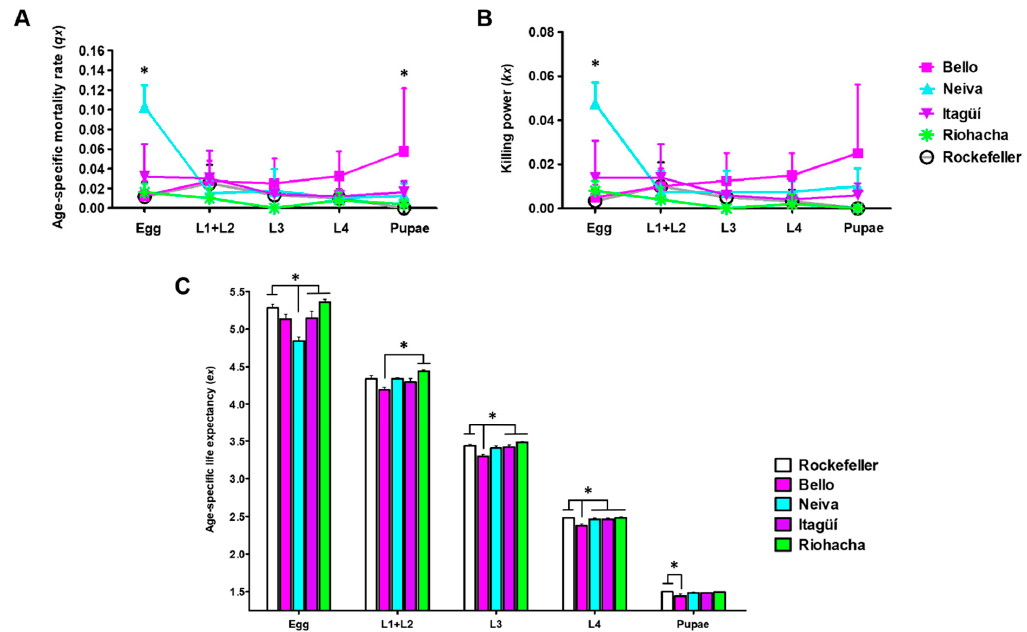
Figure 4. ( A ) Age-specific mortality rate ( qx ), ( B ) killing power ( kx ), and ( C ) age-specific life expec- tancy ( ex ) of Colombian Ae. aegypti populations reared at 28 ± 1 °C temperature, 80 ± 5% relative humidity, and 12 h light: 12 h dark photoperiod. Mean and standard deviation (SD) are shown. The total number of replicates were: Bello and Neiva (4); Itagüí and Riohacha (5), and Rockefeller control (6). Each replicate started from a cohort of 100 eggs. One-way analysis of variance (ANOVA) was conducted (* p < 0.05). A Bonferroni post-hoc test to account for multiple comparisons between pop- ulations of Ae. aegypti is presented in Table S2.